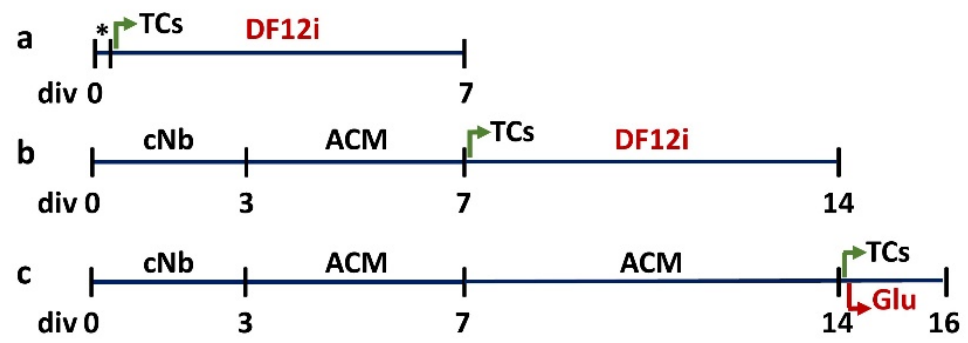
Figure 1. Experimental conditions used to evaluate the neuroprotective potential of TCs for DA neurons in midbrain cultures. ( a ) Standard culture conditions in which DF12i is used to maintain the cultures until div7 after an initial period of 2 h in DF12 medium supplemented with 10% FCS to favor cell attachment (*). ( b ) Culture conditions in which the exposure to DF12i medium between div7–14 is preceded by a period of maturation in cNb and then in ACM. ( c ) Culture conditions in which the initial period in cNb is followed by incubation in ACM until termination of the cultures, at div16. In ( a , b ), DA cell death, which is spontaneous, results from the presence of iron in the formulation of DF12i, and in ( c ), from an exposure to exogenous glutamate